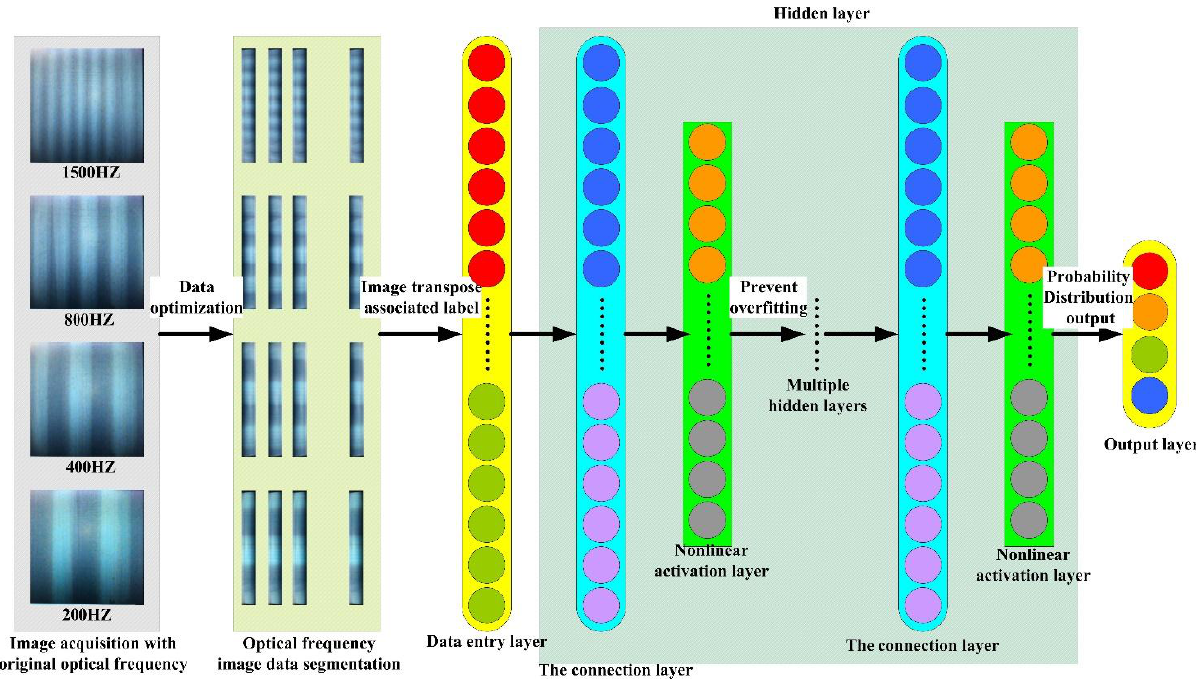
Figure 4 . Deep neural network architecture